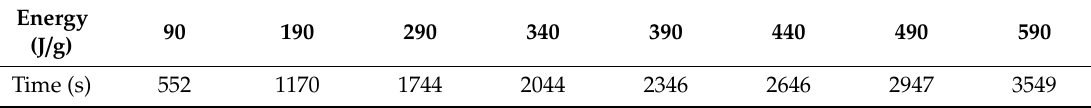
Table 1. Time used for each energy of